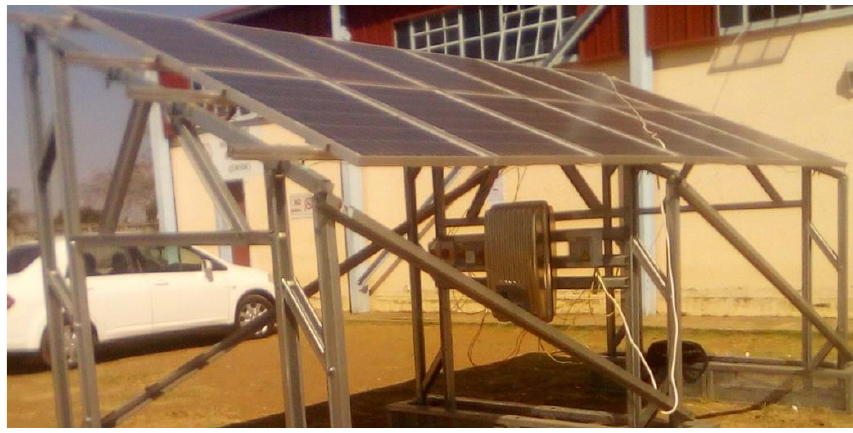
Figure 3. Ground- mounted solar PV modules at Capricorn TVET